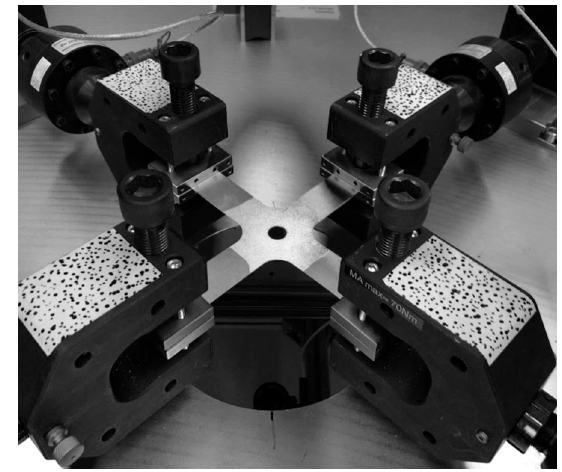
Figure 15. Biaxial tensile testing machine.